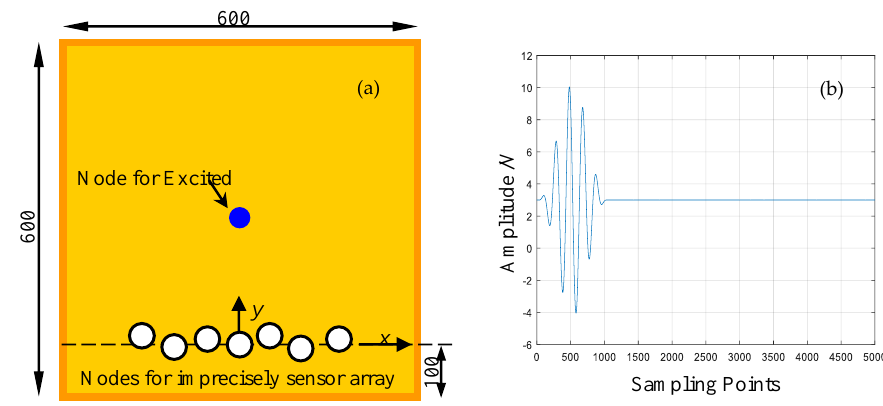
Figure 3. (a) Finite element method (FEM) model with error position of sensor array, (b) excitation signal. Table 1. The coordinates (x, y) of FEM nodes selected for sensor array.